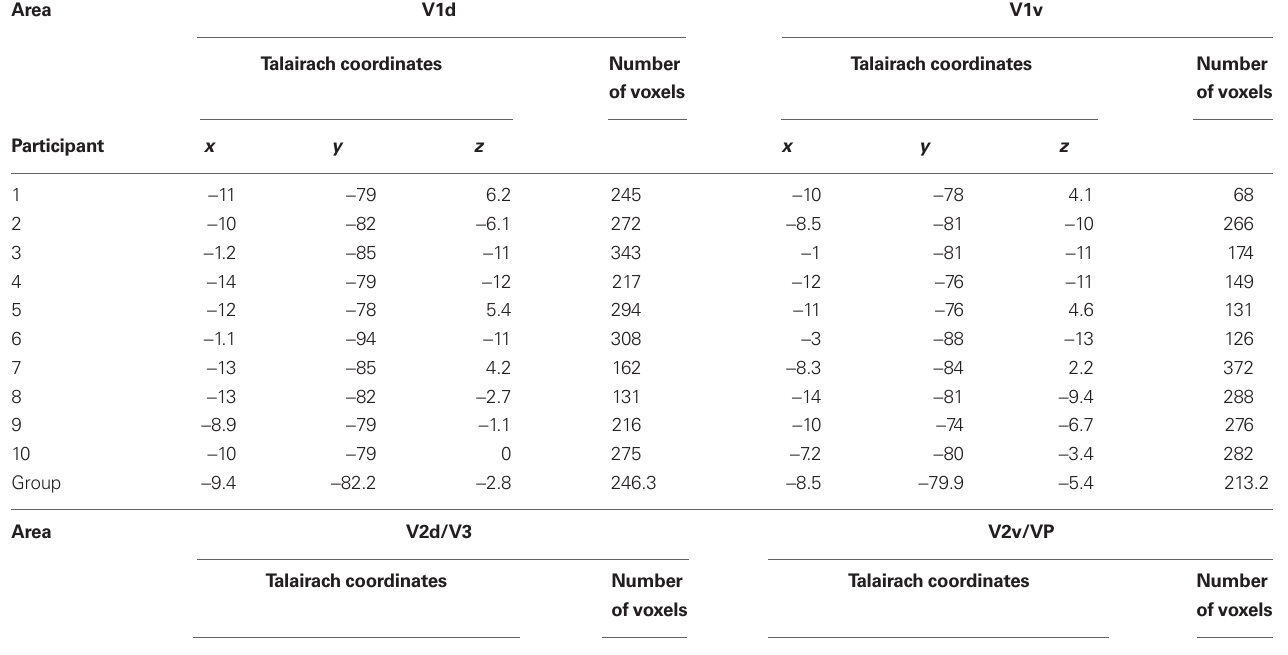
Table 1 | Talairach coordinates and sizes of ROIs for all